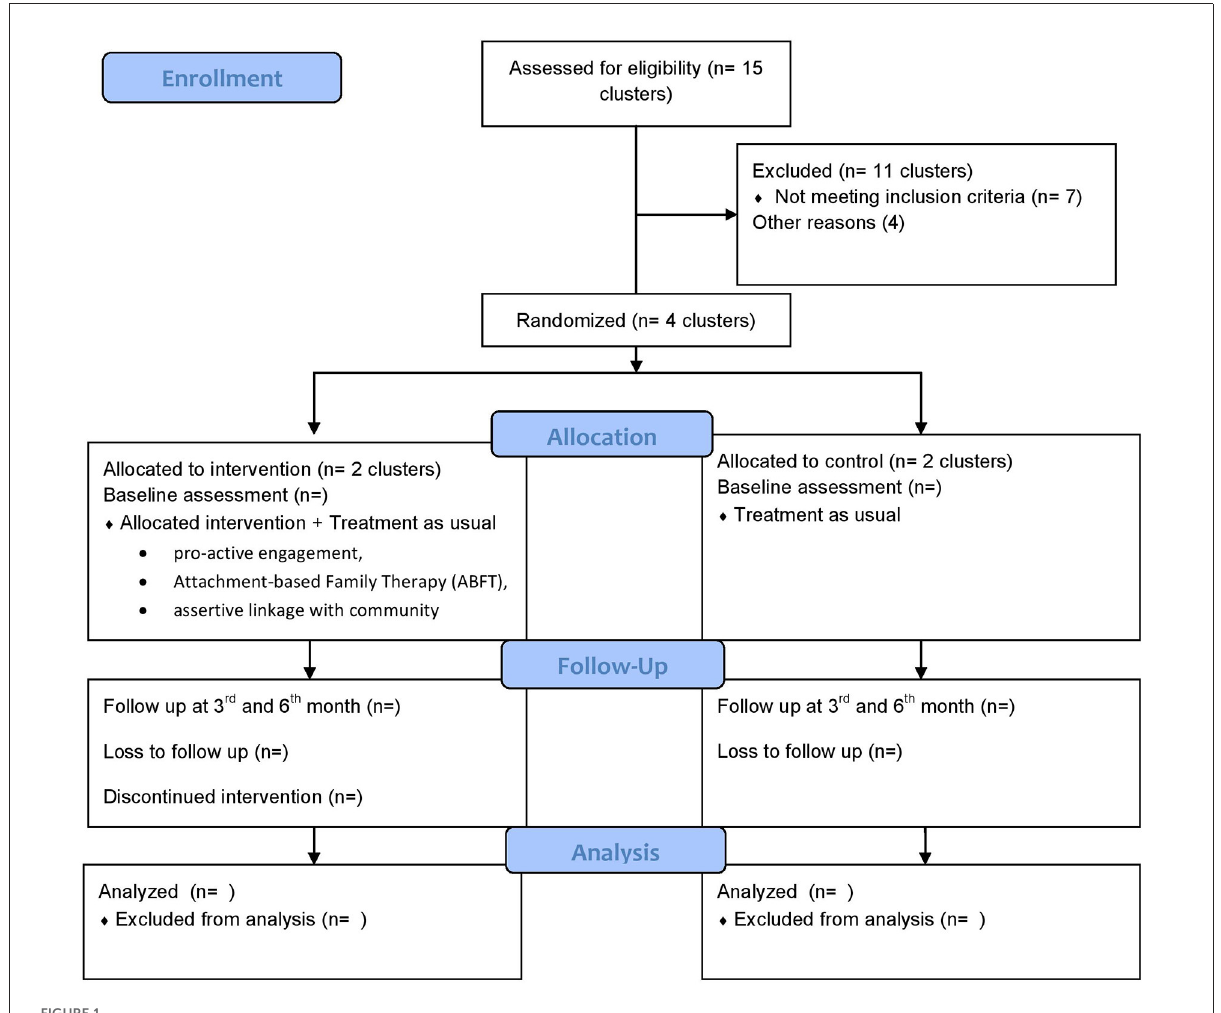
FIGURE1 Consort flow